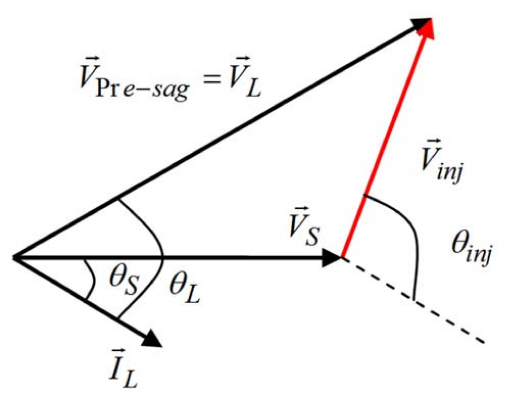
Figure 2. Phasor diagram of the pre-sag compensation